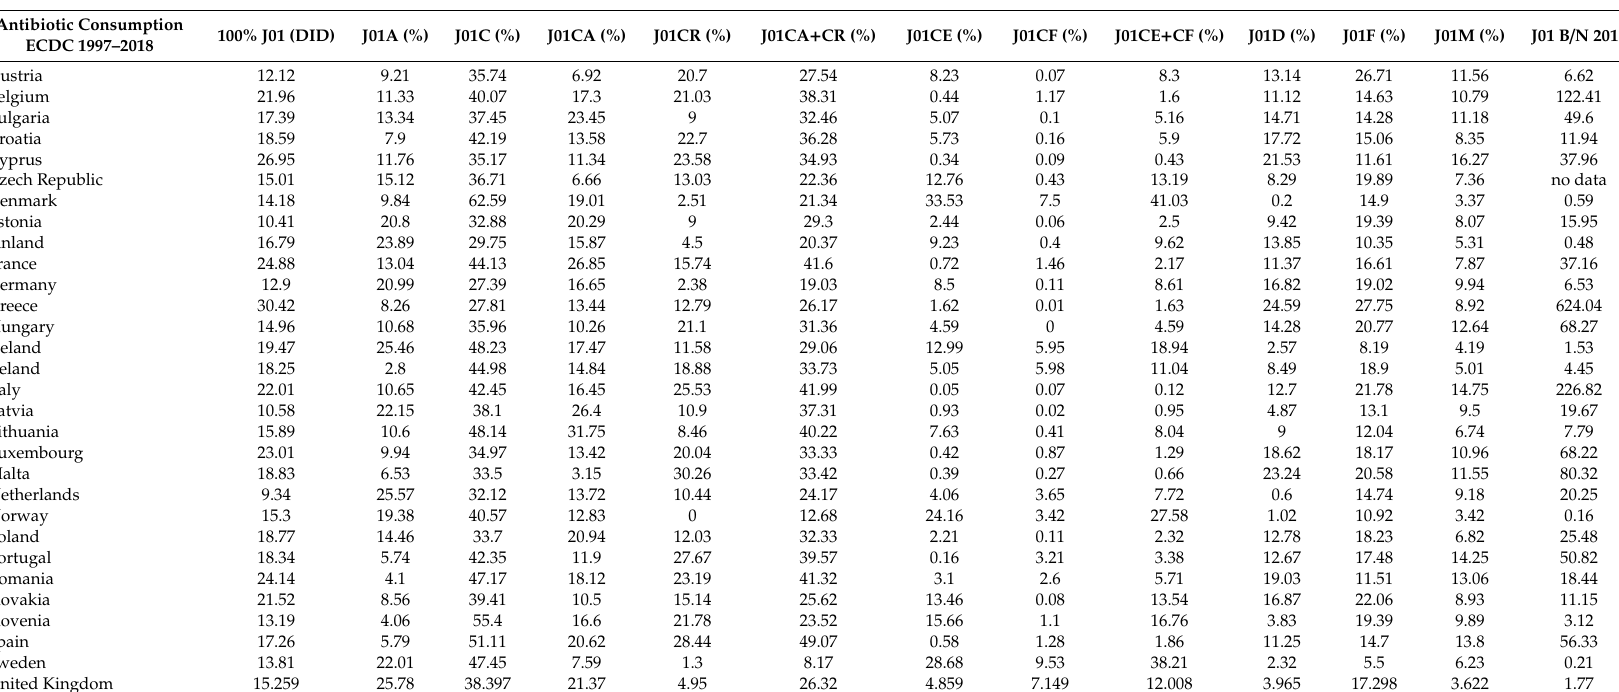
Table 2. Average, yearly antibiotic consumption in 30 European countries for 1997–2018 (22 years) derived from the ECDC yearly reports. Total antibiotic consumption for systemic use (J01), expressed as defined daily dose (DDD) / 1000 inhabitants / day (DID). Other classes of antibiotics at ATC Level 3 and 4 (for the penicillin group / J01C / ) consumed has been featured as the relative share of the total consumption and estimated in percentage